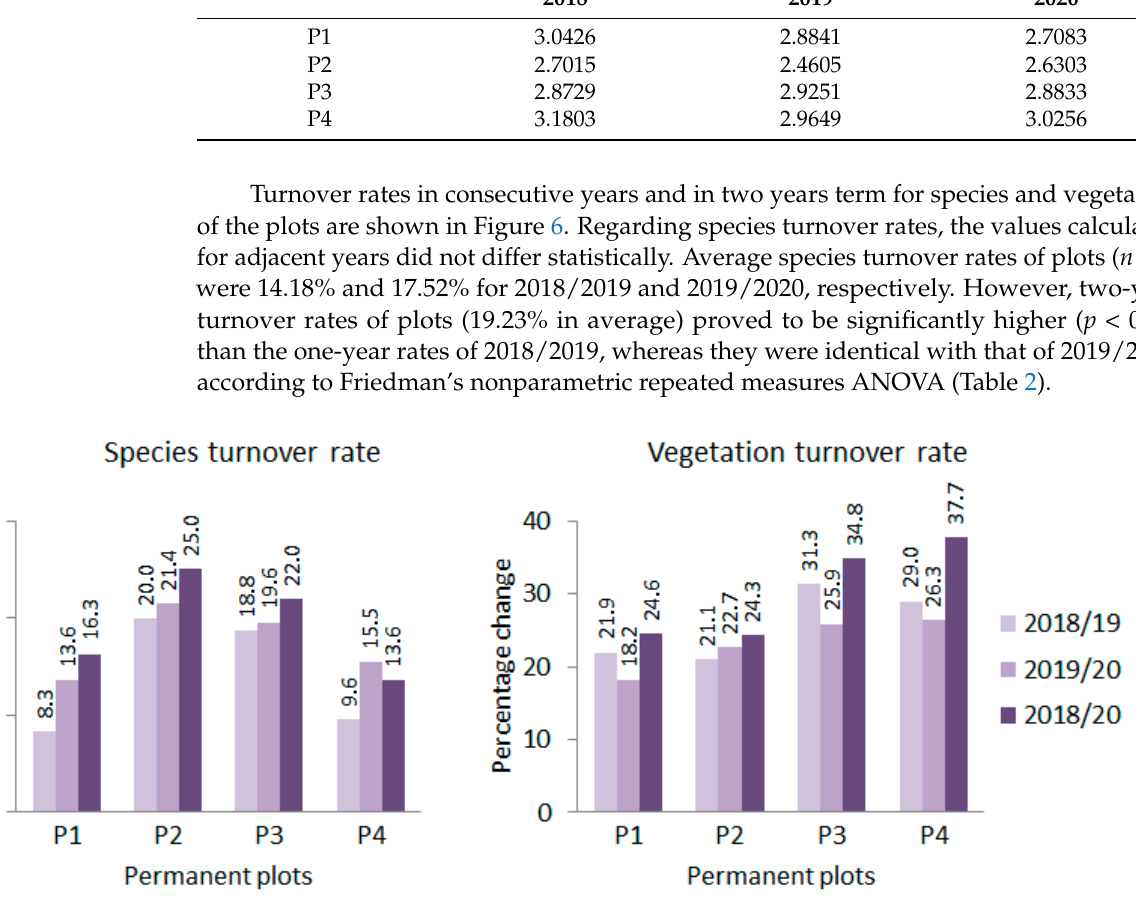
Figure 6. Species and vegetation turnover rates in four permanent plots (P1–P4) of the Natura 2000 loess grassland at “Pócalja”, Central Hungary. Table 2. Results of statistical tests on species- and vegetation turnover rates according to Friedman’s nonparametric repeated measures ANOVA followed by Dunn’s multiple comparisons test. (* = indicates significant differences, ns = not significant.)